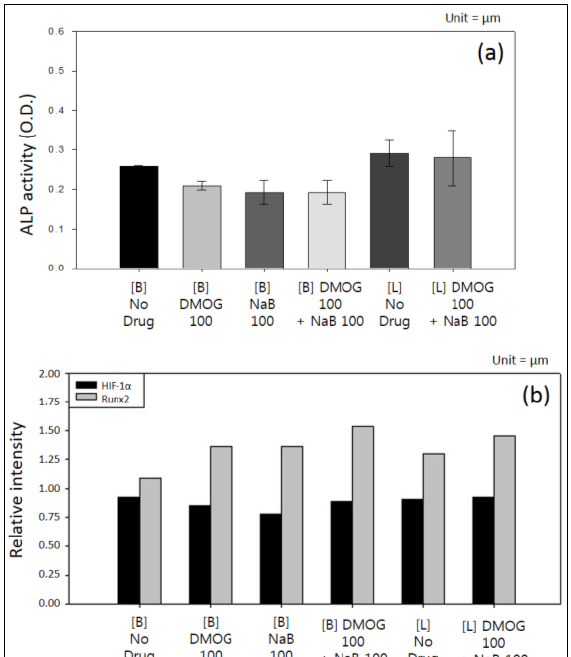
Figure 13. ( a ) Assays of alkaline phosphatase activity, ( b ) and expression of HIF-1α and Runx2 by the delivery of with and without DMOG/NaB through bolus and local modes.